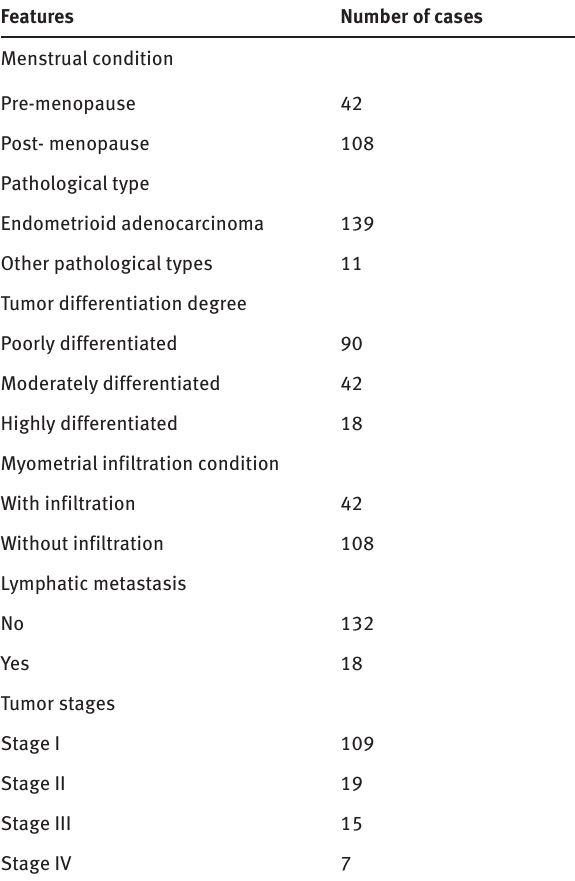
Table 1: General Conditions of the Patients